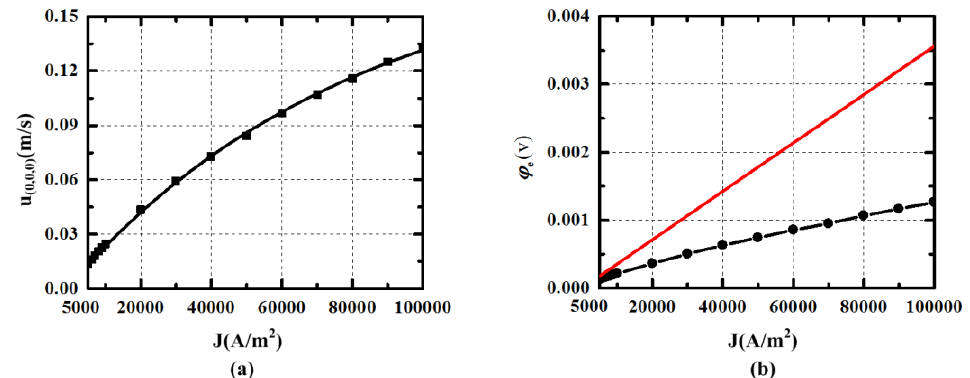
Figure 8. The velocity u (0,0,0) in central channel and the potential difference φ e between the two energized electrodes generated by the pump at current density J in simulation.